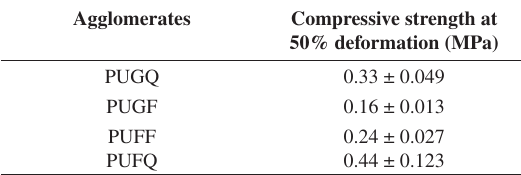
Table 3. Compressive strength of the PUs